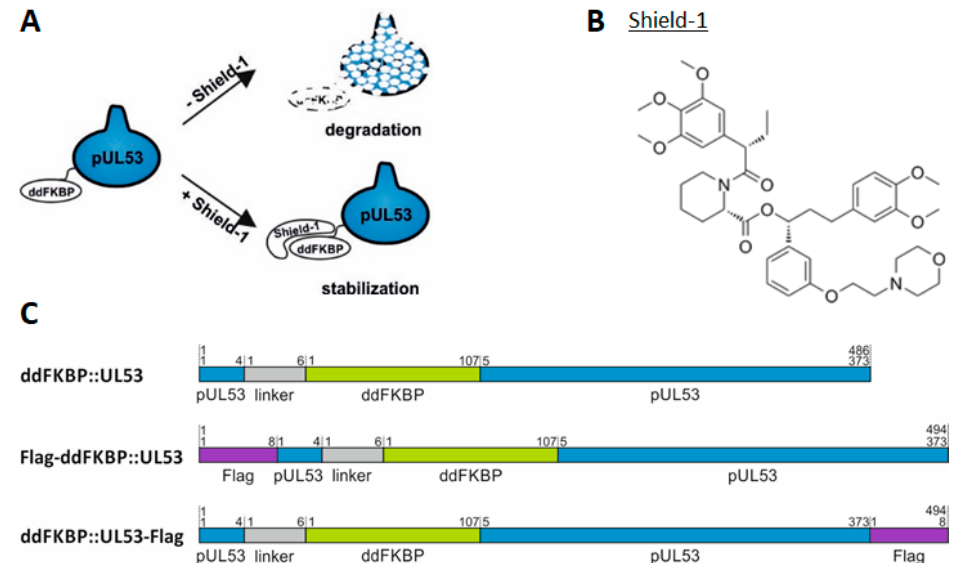
Figure 12. Principle of the Shield-1-regulated protein stability through fusion with a destabilizing domain. ( A ) Schematic illustration of the regulatory system, in which pUL53 is fused to an unstable variant of the FK506-binding protein FKBP (ddFKBP) that is stabilized by interaction with the synthetic ligand Shield-1. ( B ) Chemical structure of the stabilizing ligand Shield-1 containing a morpholine group that enhances its intracellular availability [55] . ( C ) Schematic illustration of ddFKBP::UL53 fusion constructs: pUL53, blue; linker region GSARQL, gray; ddFKBP, green; Flag-tag, purple; amino acid positions are represented by numbers.